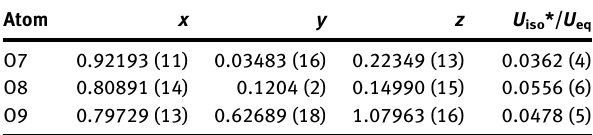
Table  : Fractional atomic coordinates and isotropic or equivalent isotropic displacement parameters (Å 